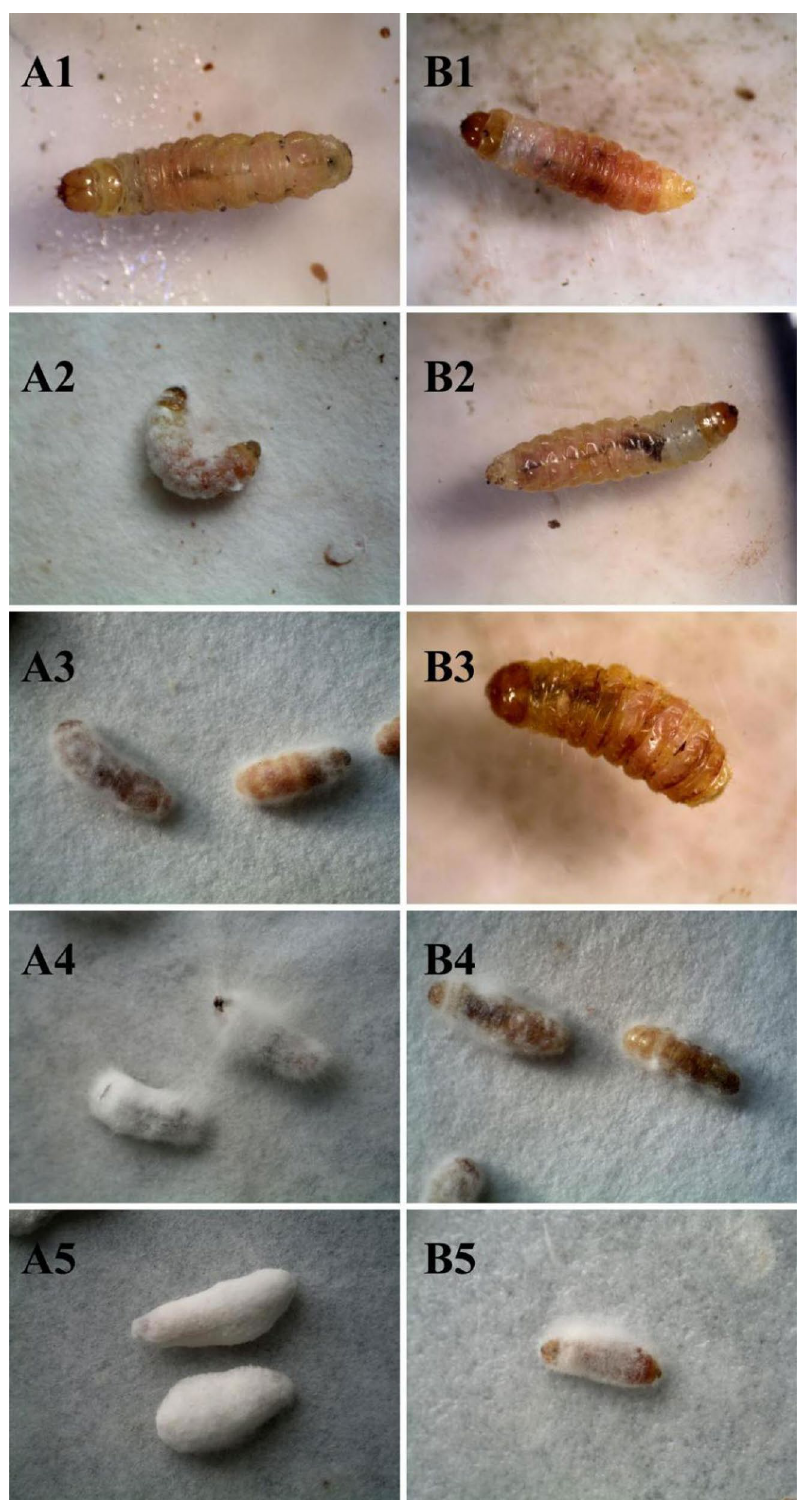
Figure 5. Comparison of the infective symptoms of A. hetaohei larvae infected by the B. bassiana treated or not treated with the epidermal mucus of the earthworm E. foetida. ( A ): treatment group 3, in which, the B. bassiana before inoculation, was not treated with the epidermal mucus of the earthworm E. foetida . ( A1–A5 ) showing the infection symptoms of larvae on the 3rd, 5th, 7th, 10th and 14th days, respectively, after inoculated. ( B ): treatment group 4, in which, the B. bassiana before inoculation, was treated with the epidermal mucus of the earthworm E. foetida . ( B1–B5 ) showing the infection symptoms of larvae on the 3rd, 5th, 7th, 10th and 14th days, respectively, after